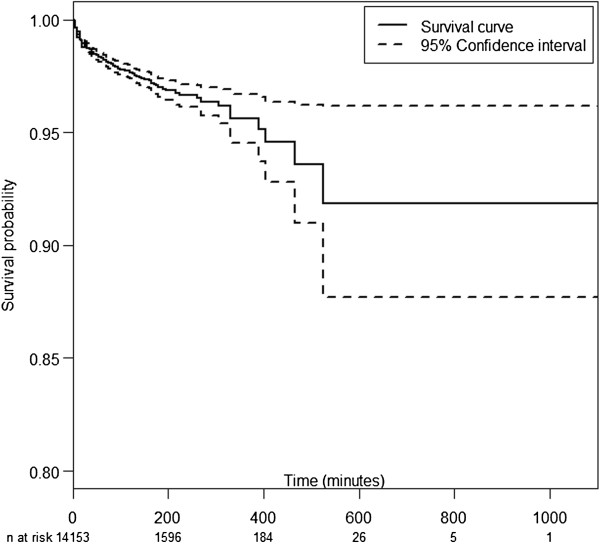
Kaplan Meier survival curve of the first intraoperative respiratory event.